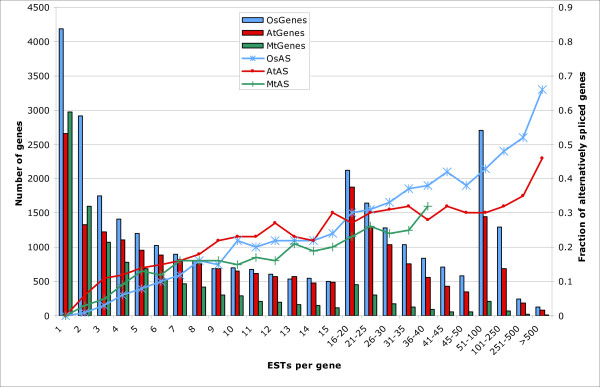
Correlation between AS frequency and EST coverage. The x-axis indicates groups of genes with certain numbers of ESTs. The primary y-axis for the bar graph indicates total number of genes within each group. The secondary y-axis for the line graph indicates the fraction of alternatively spliced genes for the group. Note that different bin sizes were used to keep the number of genes in each group greater than 500 in At and Os. AS data from groups with fewer than 80 genes in Mt were removed to reduce noise. Lj data were not shown as only the first six groups have more than 80 genes.